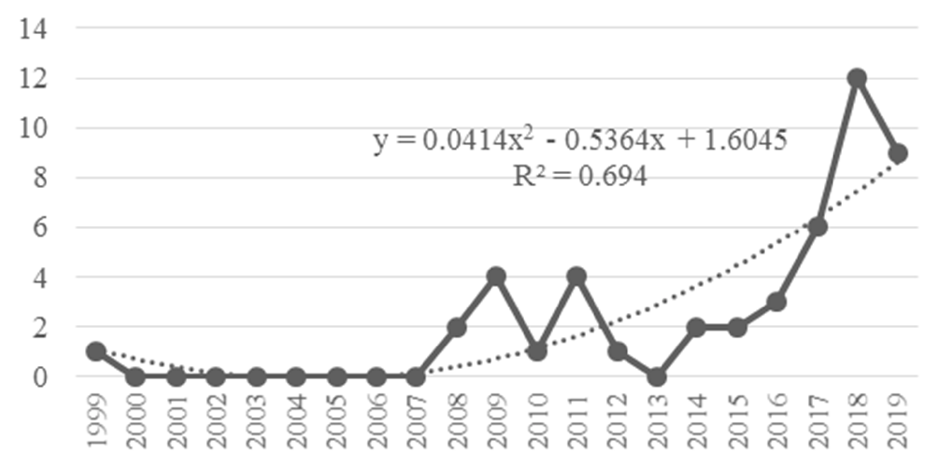
Figure 2. Trend of publications in Scopus ∪ WoS. Source: own elaboration.